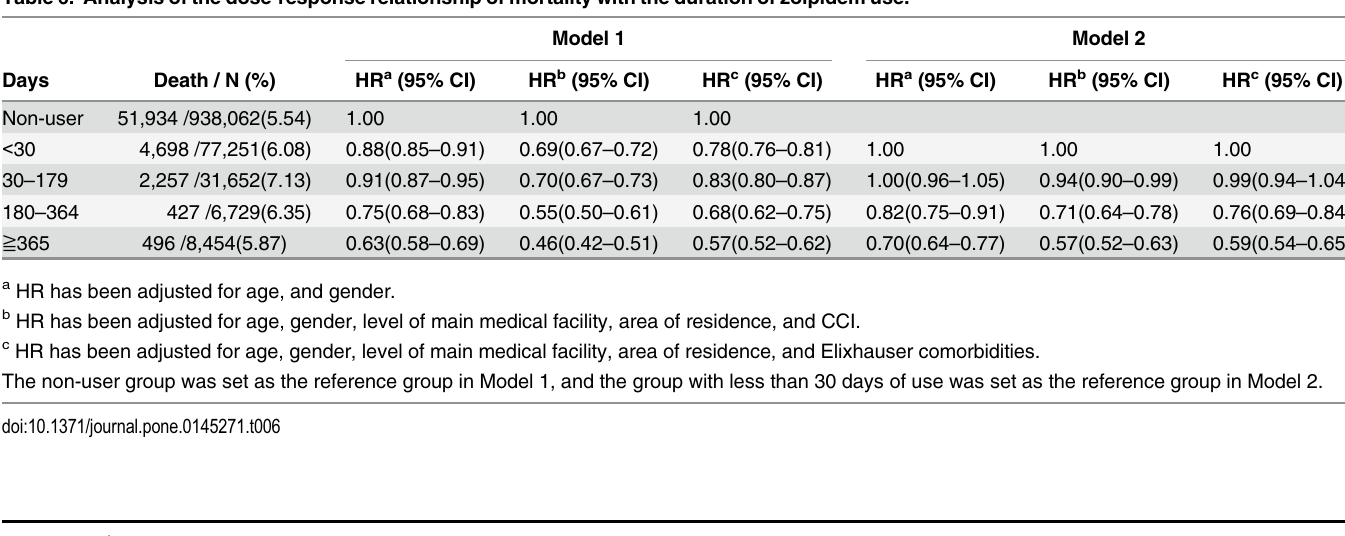
Table 6. Analysis of the dose-response relationship of mortality with the duration of zolpidem